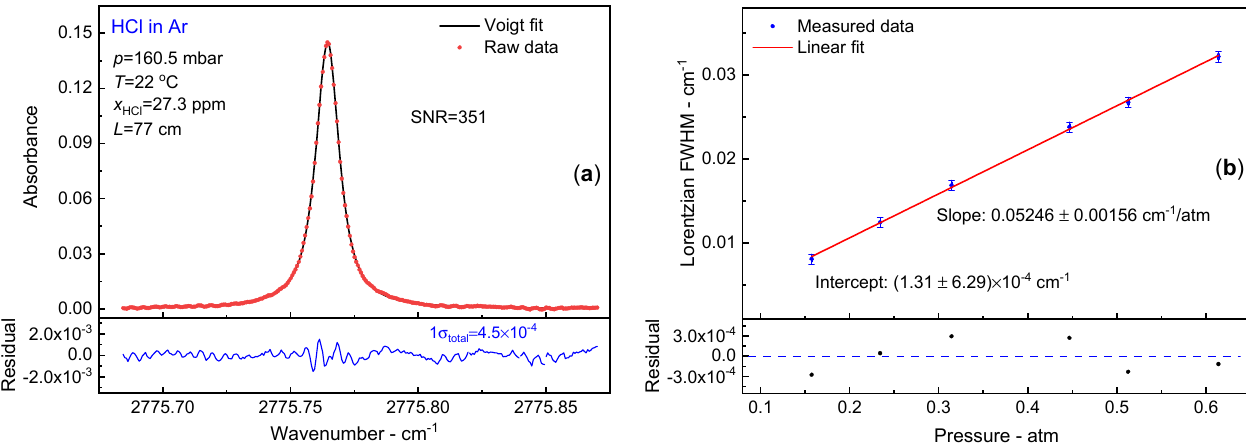
Figure 4. ( a ) Measured Ar-broadened HCl absorption spectra at 160.5 mbar and the fitting residual; ( b ) Measured Ar induced pressure broadening with a linear fitting model. The residual between fit and data is shown below.